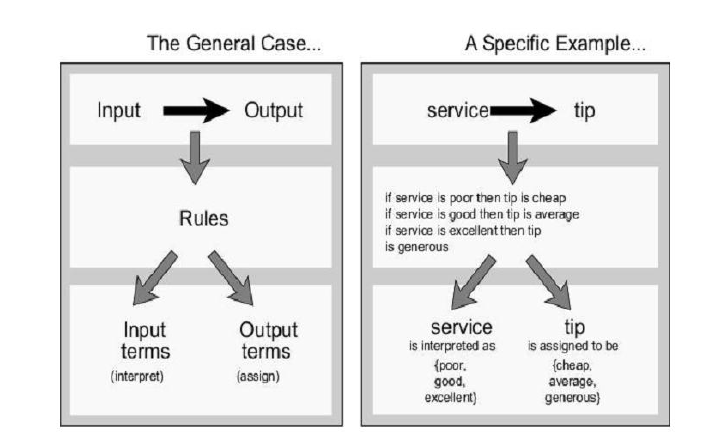
Figure 3. Overview of Fuzzy